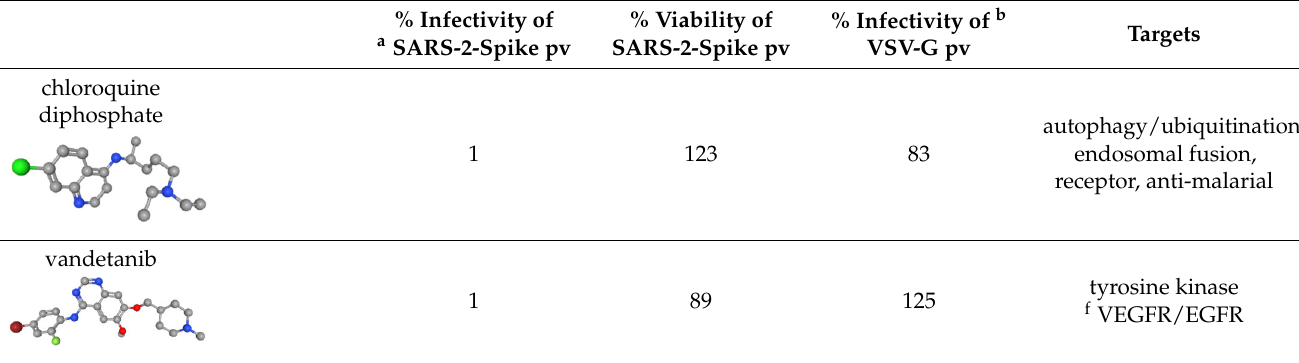
positives, indicating the importance of the exact chemistry in inhibition (Table S1). Table 1. A list of top hits with ≥ 65% VSV-G infectivity in a negative screen. Table 1. A list of top hits with ≥65% VSV-G infectivity in a negative screen. Table 1. A list of top hits with ≥65% VSV-G infectivity in a negative screen. % Infectivity of % Viability of a SARS-2-Spike pv % Infectivity of % Viability of % Infectivity of % Viability of % Infectivity of a SARS-2-Spike pv SARS-2-Spike pv a SARS-2-Spike pv